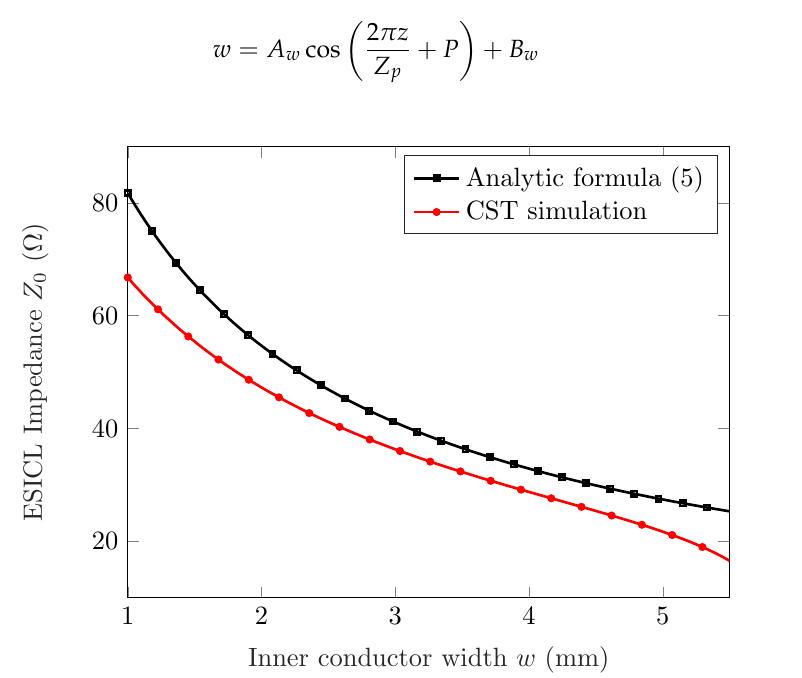
Figure 5. Variation of the impedance ( Z 0 ) of the ESICL as a function of the inner conductor width. B = 2.618 mm, A = 6 mm, t = 0.866 mm. Comparison between analytic formula of Equation (5) and simulation with a computer simulation technology (CST) electromagnetic (EM) solver.